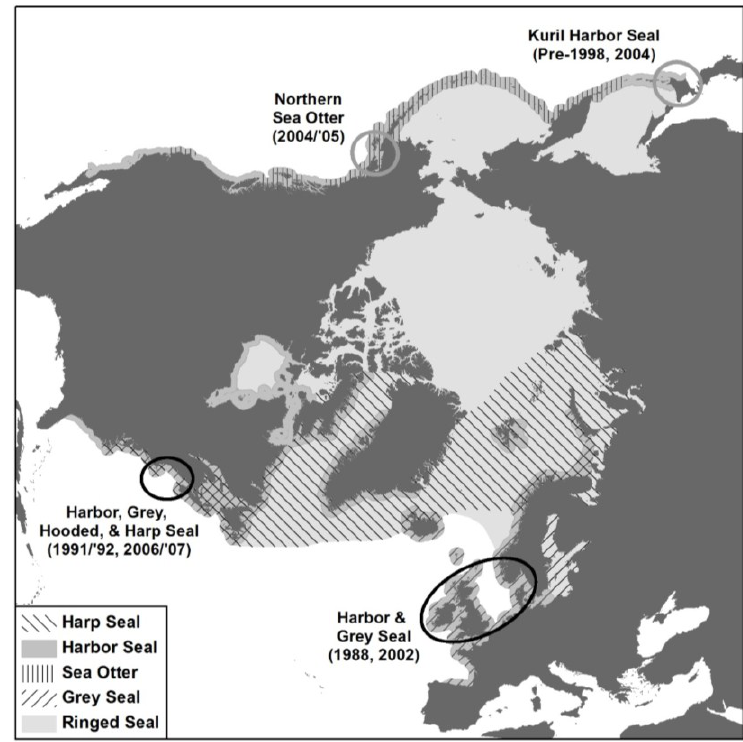
Figure 4. North polar azimuthal equidistant projection showing the location of 1988 and 2002 PDV epidemics in the northeastern Atlantic (lower right black oval); two mortality events in the northwestern Atlantic in which PDV infection was confirmed (left black oval); putative PDV-associated Kuril seal mortalities, Hokkaido, Japan (upper right grey circle); and presumptive PDV mortality in northern sea otters in southern Alaska (upper left grey circle). Distribution ranges or harbor, grey, harp, ringed seals and sea otters are